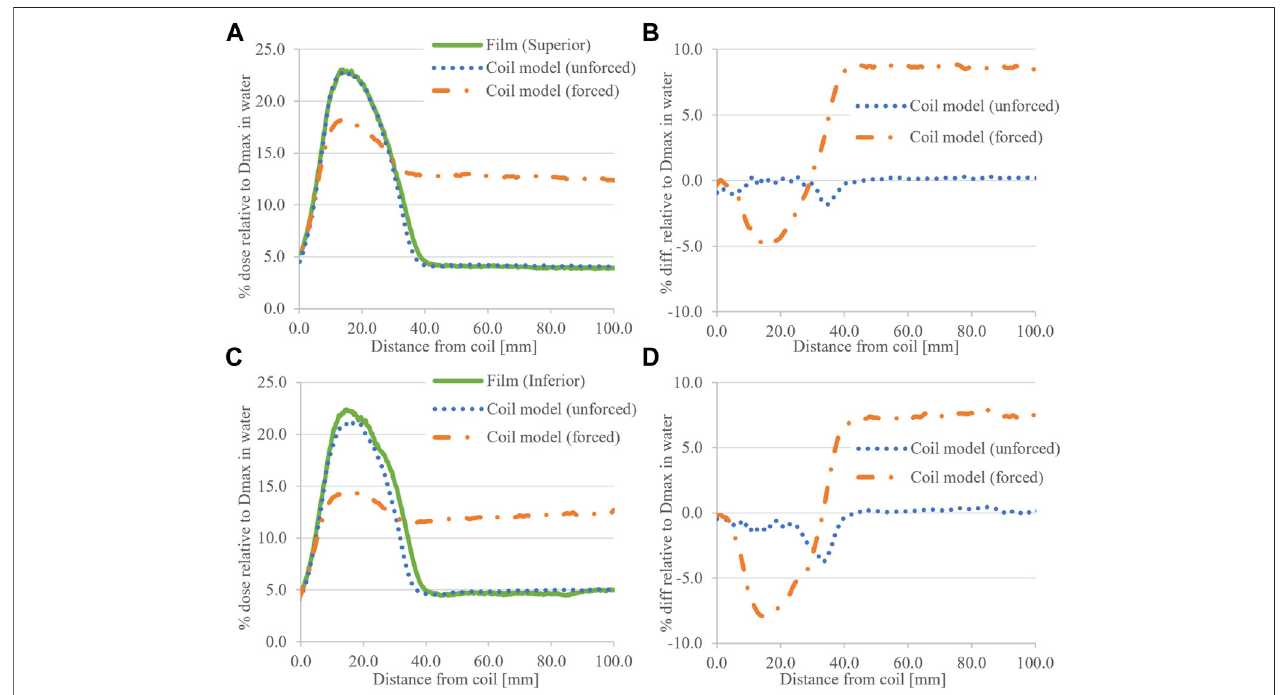
FIGURE 6 | Calculated ESE dose for the 8.0 × 22.0 cm 2 fi eld with the coil model compared to fi lm data. (A) shows the superior (+Y) data with (B) associated difference plots. Similarly for (C) inferior ( − Y) and (D) associated difference plots. The RED status for the air around the coil is provided in